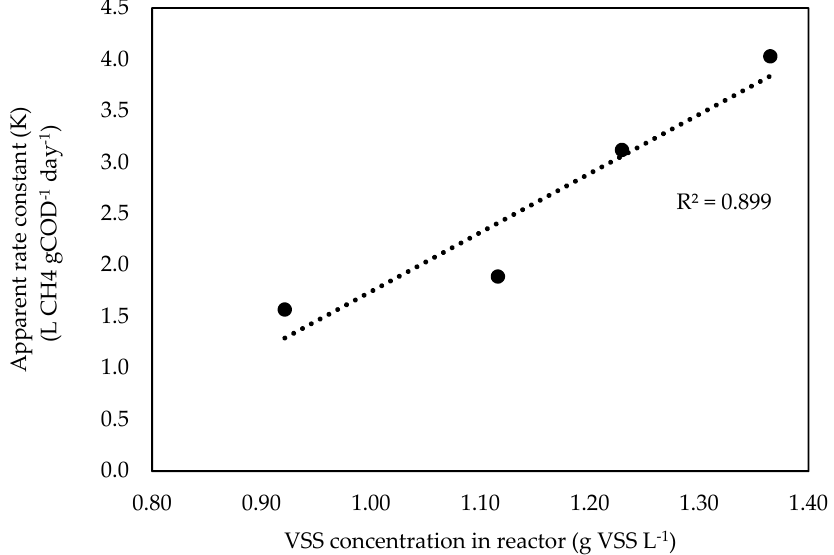
Figure 9. Relationship between apparent rate constant ( K ) and influent substrate concentration.